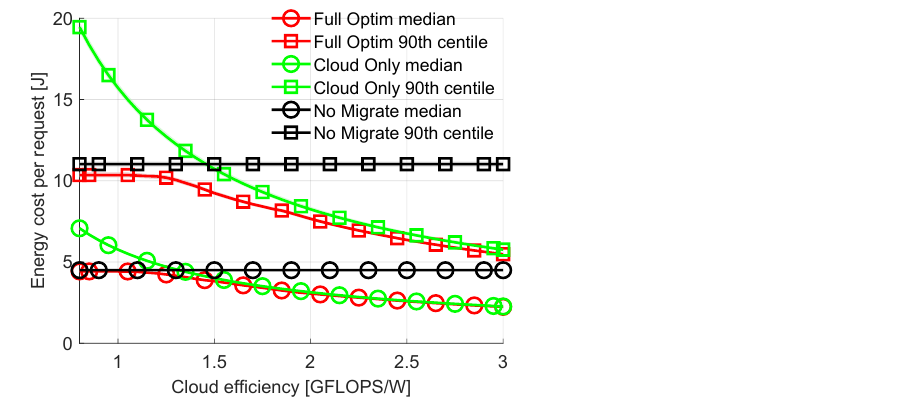
Figure 4. Comparison of energy cost per request with varied computational efficiency of cloud.